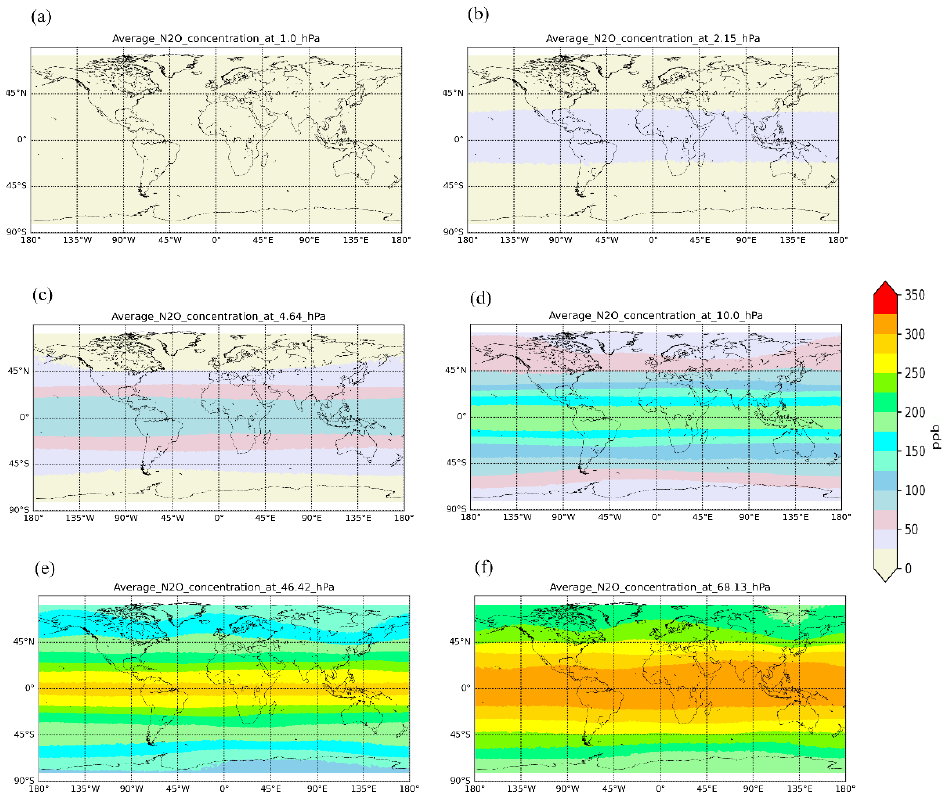
Figure A1. Average N 2 O concentration distribution of each layer from 2005 to 2019: ( a ) 1 hPa; ( b ) 2.15 hPa; ( c ) 4.64 hPa; ( d ) 10 hPa; ( e ) 46.42 hPa; ( f ) 68.13 hPa.